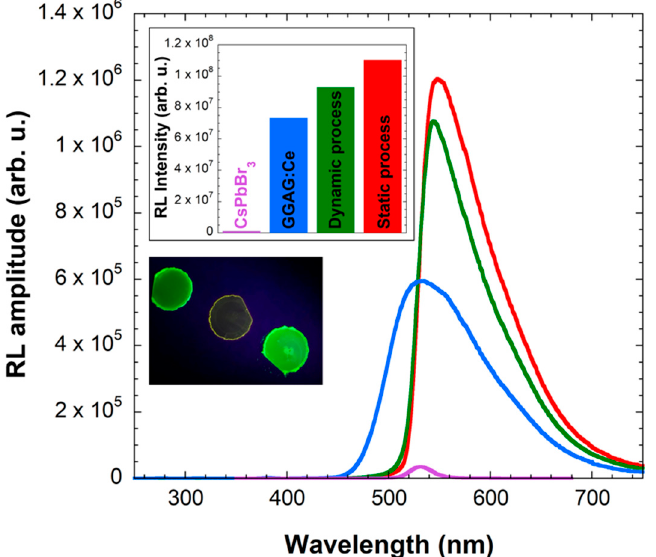
Figure 4. RL spectra of prepared CsPbBr 3 films on glass by the static process (purple line) and on GGAG:Ce by the static process (red line) and the dynamic process (green line), compared to the pure GGAG:Ce wafer (blue line). Graph in the inset: Integrated RL intensities of presented spectra. Photograph in the inset, from left to right: CsPbBr 3 film on GGAG:Ce prepared by the static process, pure GGAG:Ce wafer, CsPbBr 3 film on GGAG:Ce prepared by the dynamic process. Note that UV illumination intensity is not homogeneous among the samples.